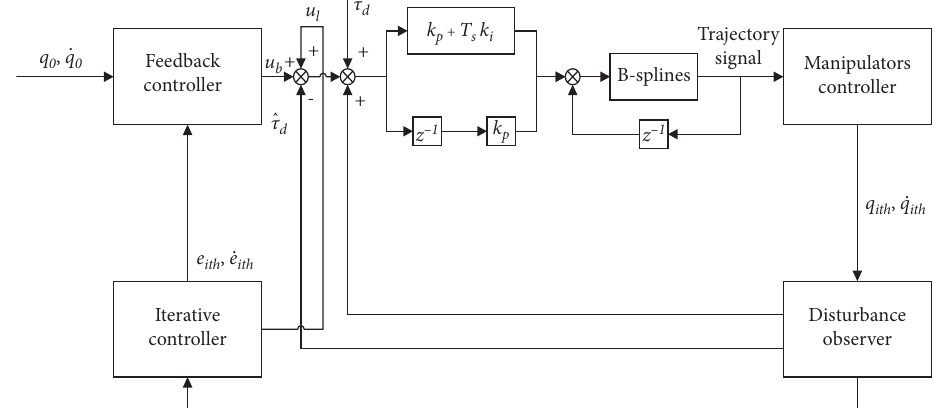
Figure 2: Configuration of iterative control scheme combined with B-spline.